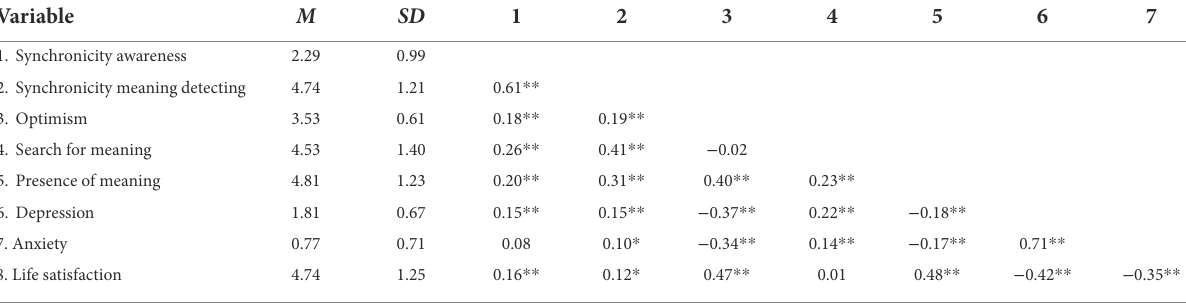
TABLE 4 Means, standard deviations, internal reliabilities and zero-order correlations of study 2.